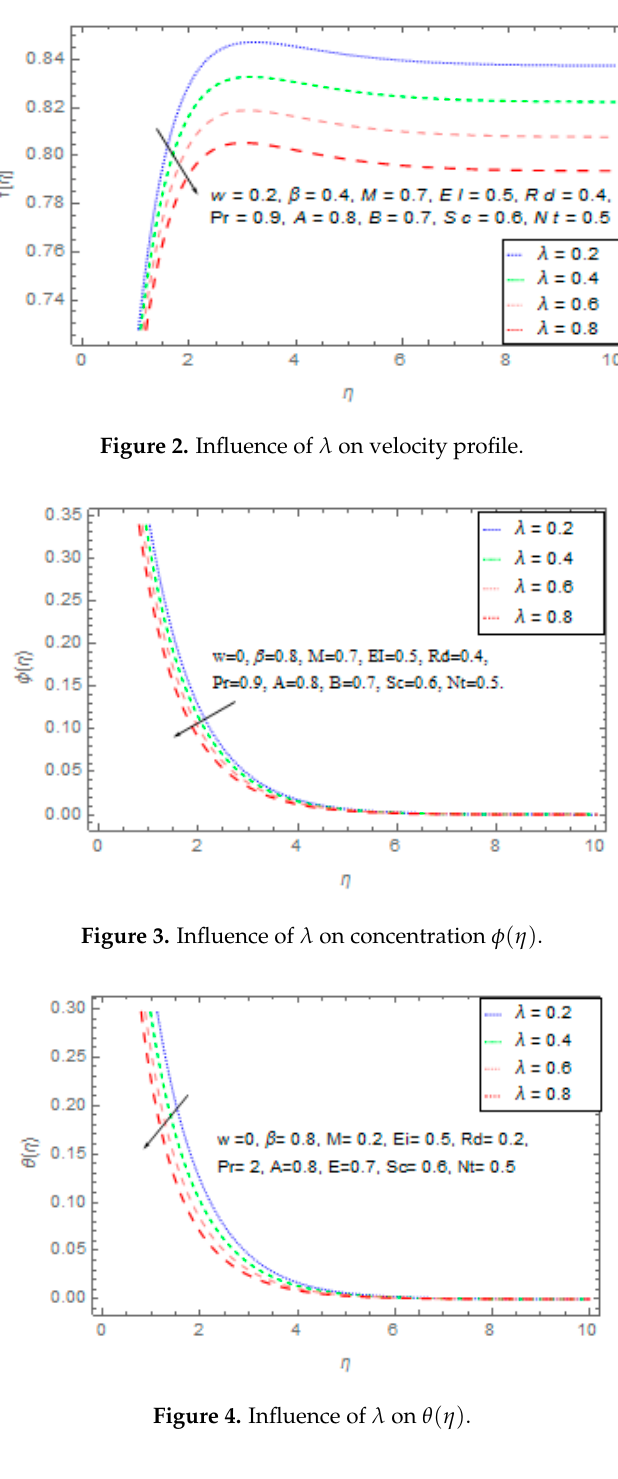
Figure 5. Influence of M on velocity Profile.